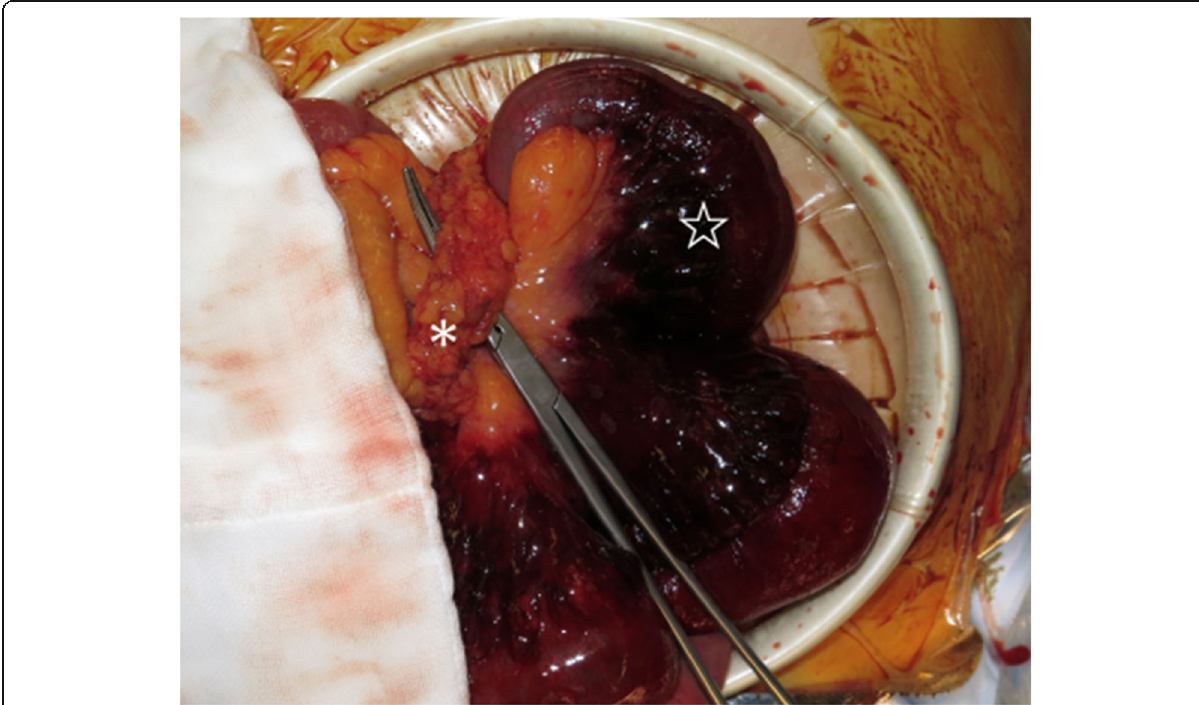
Fig. 2 Intraoperative findings. The small intestine was incarcerated through the omental hiatus ( ※ ) from the right to left side. The intestine ( ☆ ) exhibited necrotic